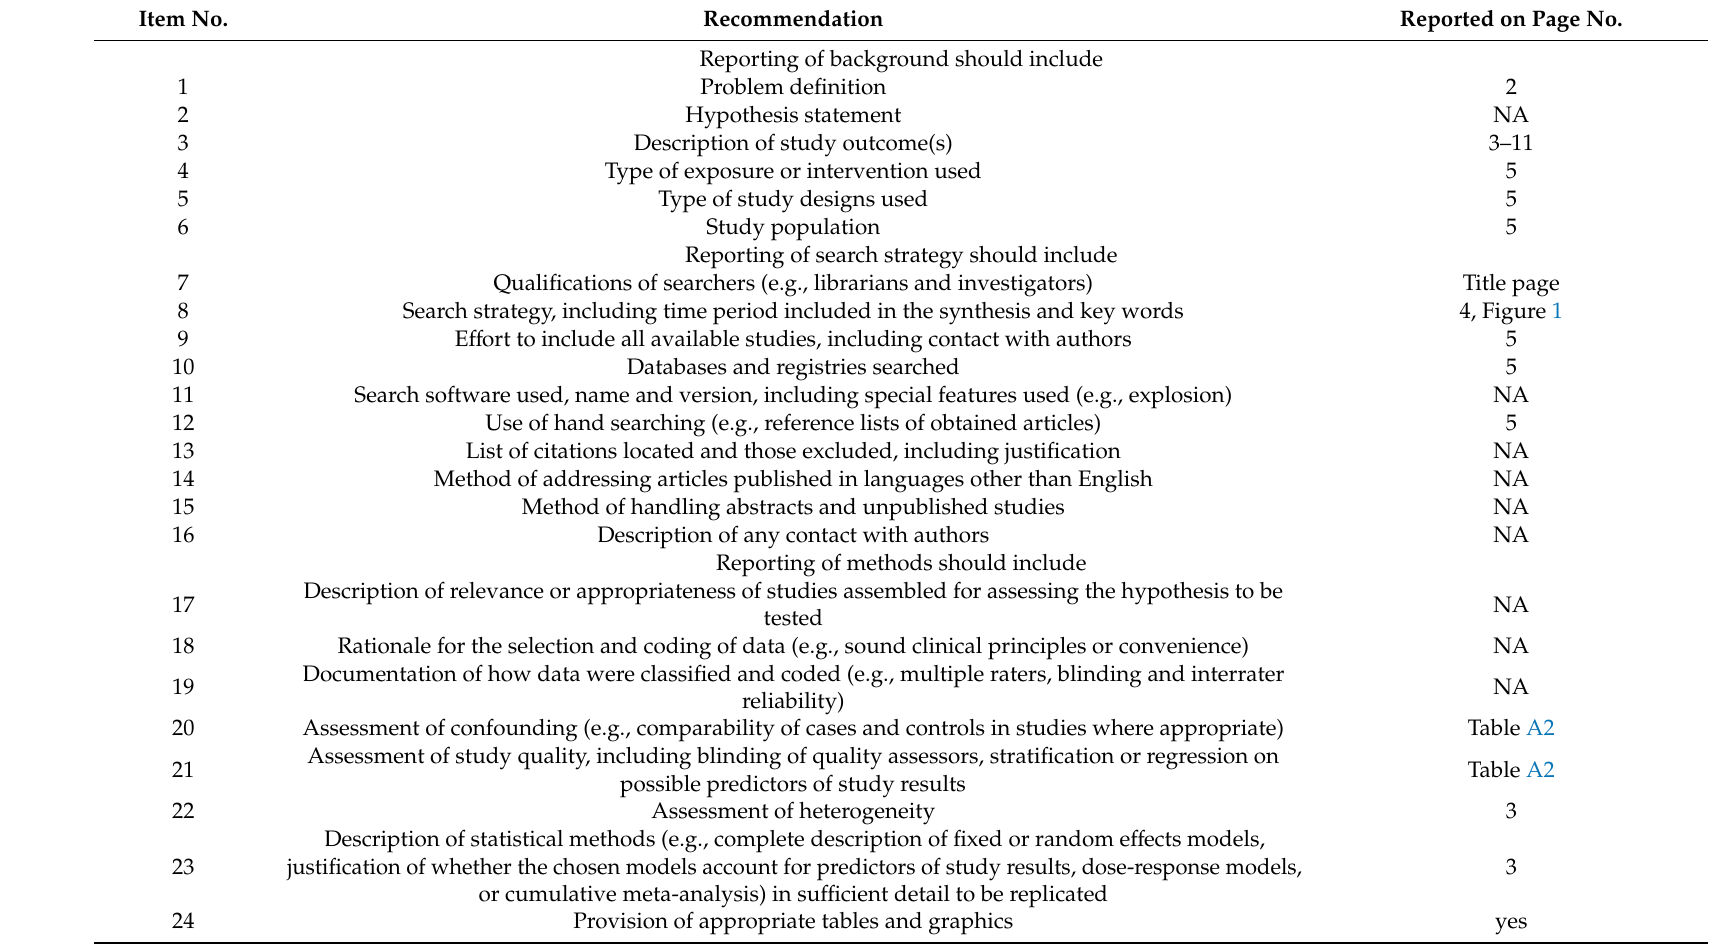
Table A1. Checklist for meta-analyses of observational